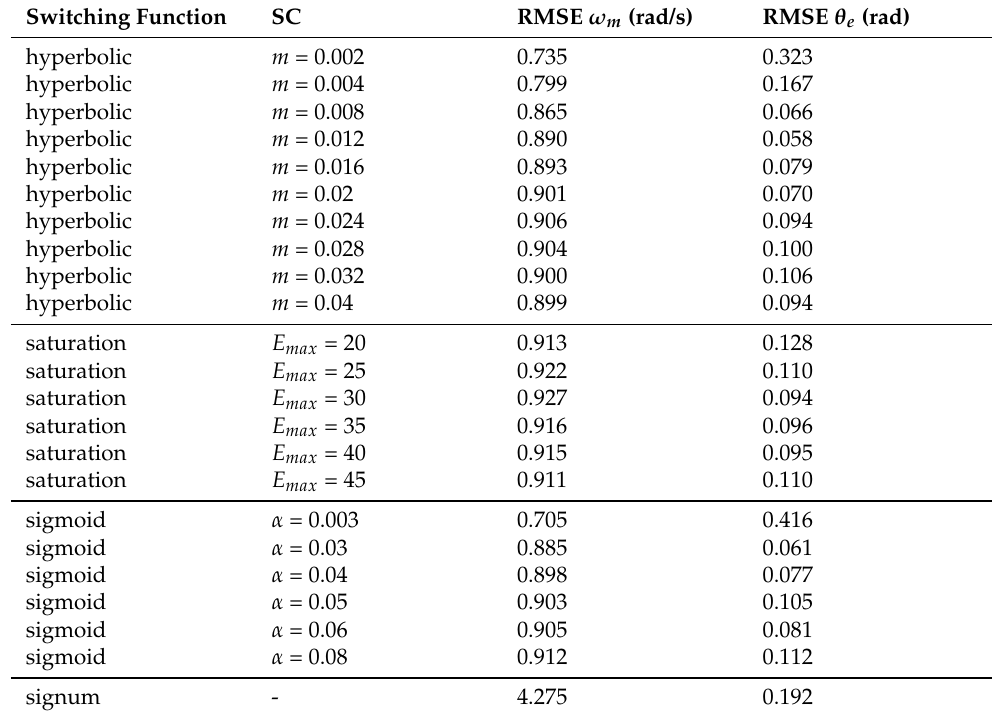
Figure 6. Experimental results for speed and position estimation with hyperbolic function, m = 0.02. Table 2. Measured RMSE values for different switching functions and